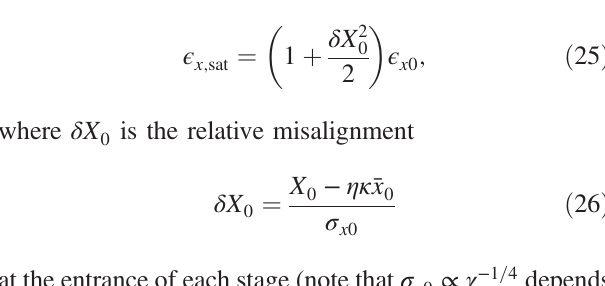
ffiffiffiffiffiffiffiffiffiffiffiffiffiffiffi p ffiffiffiffiffiffiffiffiffiffiffi 4 = 2 π a